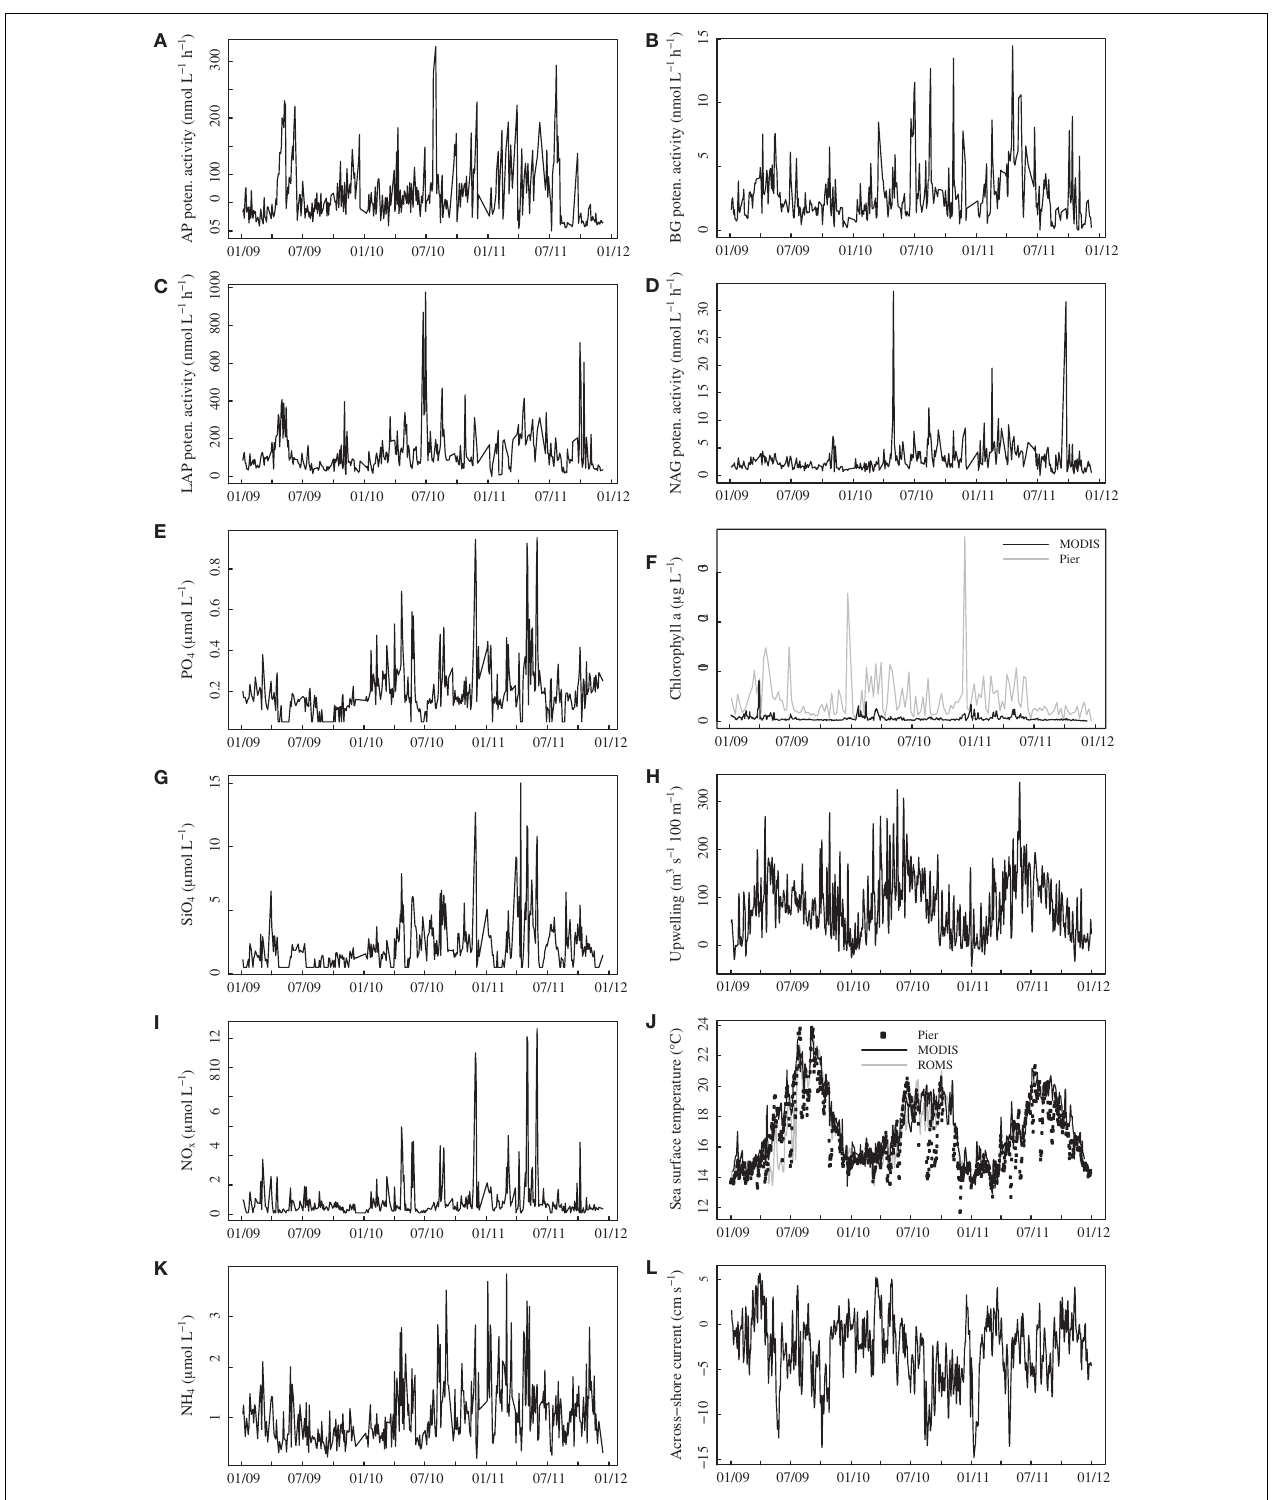
MODIS satellite data from the 3600-km 2 region (black line), and ROMS model output from the 3600-km 2 region.The Bakun upwelling index (H) is shown for the Southern California Bight at 33˚N, 119˚W. Across shore (L) currents were derived from ROMS model outputs (surface 50m) for the 3600-km 2 region. AP, alkaline phosphatase; BG, β -glucosidase; LAP, leucine aminopeptidase; NAG, N